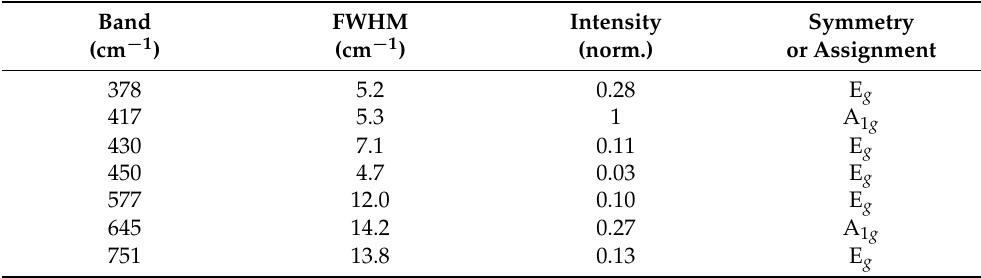
Figure 4. The instrument for compressing the alumina ball and the glass plate. The peaks associated with alumina and glass were then fitted using information from the literature and the Renishaw Wire 5 software. Their positions and widths at half height are detailed in Tables 1 and 2. These fits of the vibration modes allow the displacement of the alumina and glass ∆ ν bands to be extracted as a function of r , the position along the spectral profile. The baseline was treated during the fitting of each spectrum. Table 1. Positions, full width at half maximum and intensity of the polycrystalline alumina bands used to fit the spectra.